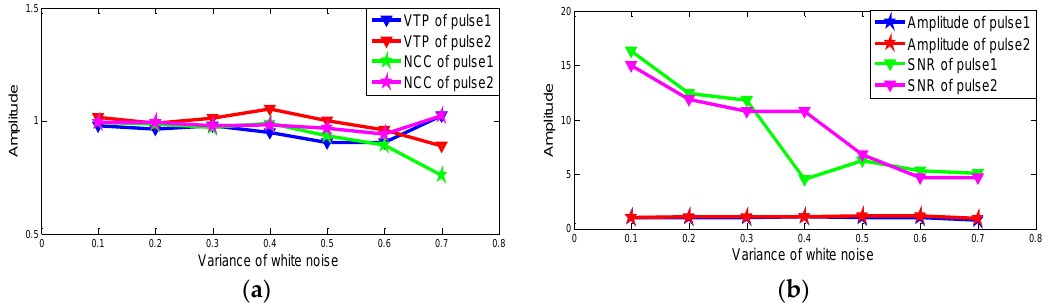
Figure 8. CEEMDAN-Henkel-SVD denoising results under different white noise variances: ( a ) The waveform of normalized correlation coefficient (NCC) and variation trend parameter (VTP) after denoising; and ( b ) The waveform of amplitude and SNR after denoising.